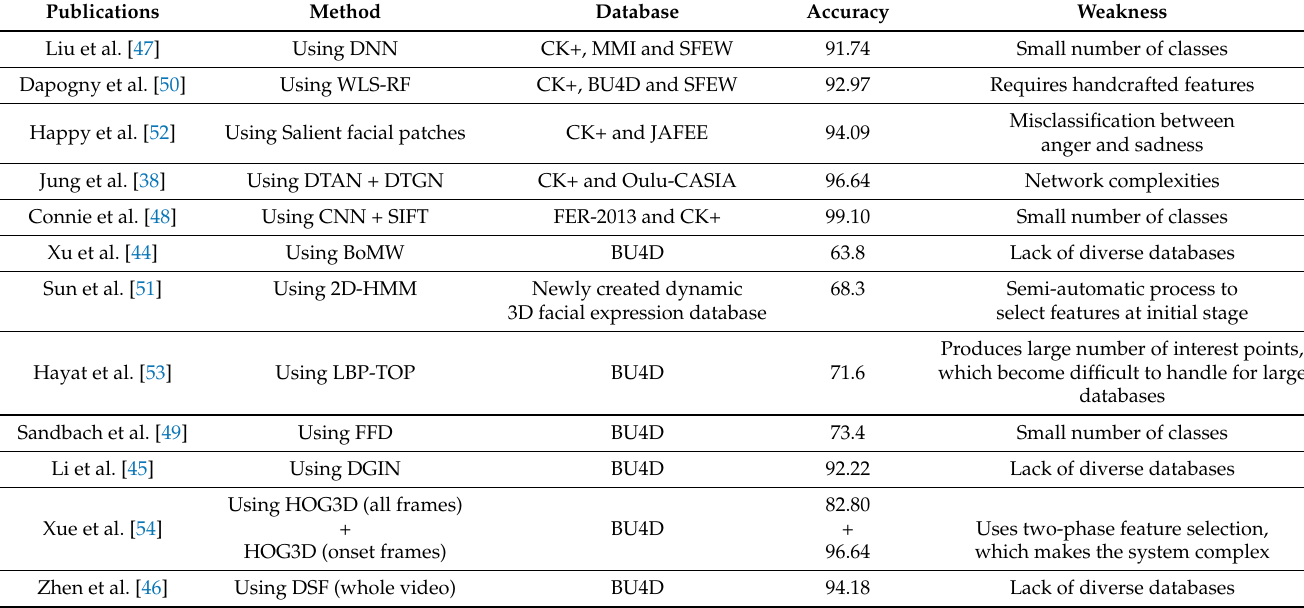
Table 1. Comparison and weaknesses of related